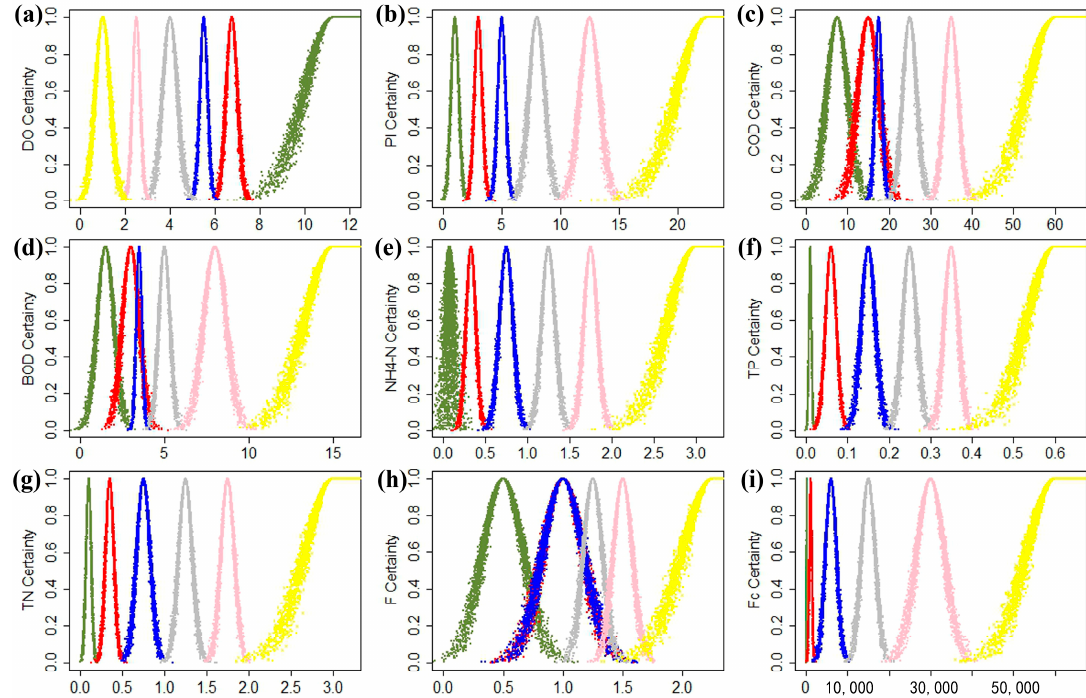
Figure 7. Forward clouds of different indexes at various water quality grades. ( a ) DO, ( b ) PI, ( c ) COD, ( d ) BOD, ( e ) NH 4+ -N, ( f ) TP, ( g ) TN, ( h ) F, and ( i ) Fc. The dark olive-green, red, blue, gray, pink, and yellow scatter cloud represent grades I, II, III, IV, V, and VI, respectively.